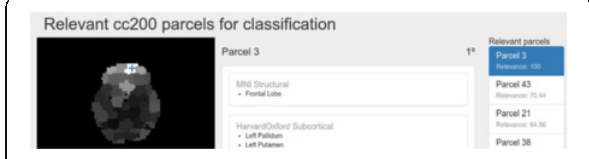
Fig. 19 (abstract A22). SVM coefficients tool showing the most relevant feature in a classification task